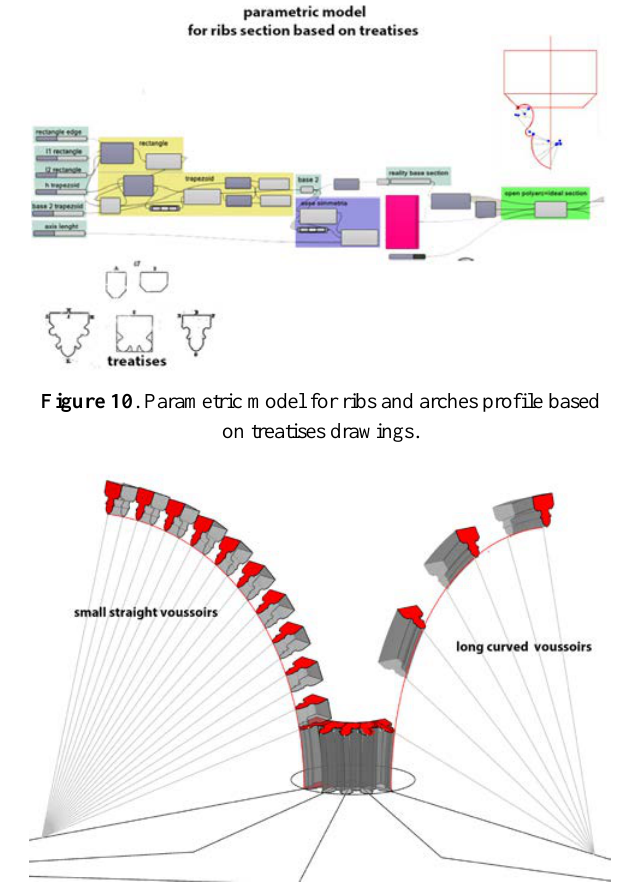
Figure 11 . Voussoirs distribution: small straight voussoirs tangent to extrusion line or long curved voussoirs generated moving the cross section along the extrusion line-